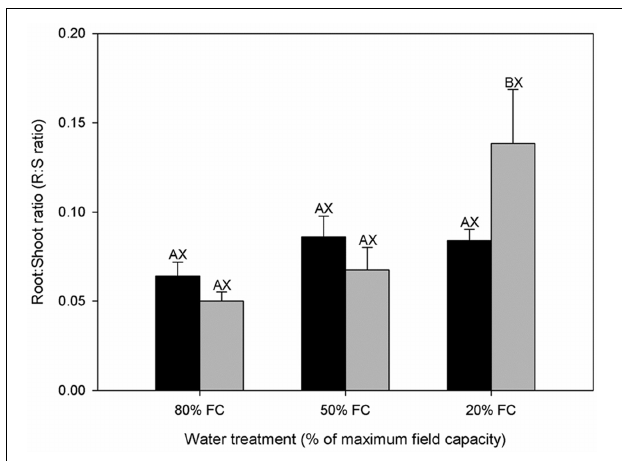
FIGURE 1 | Root:Shoot ratio (R:S ratio) of diploids (black bars) and hexaploids (gray bars) under different soil water conditions (80% of maximal field capacity (FC), 50% FC, 20% FC). Each value is presented as mean ± SE. Letters distinguish between statistically separable ( p < 0.05) values for different water treatments (A, B, C) and for different cytotypes (X,